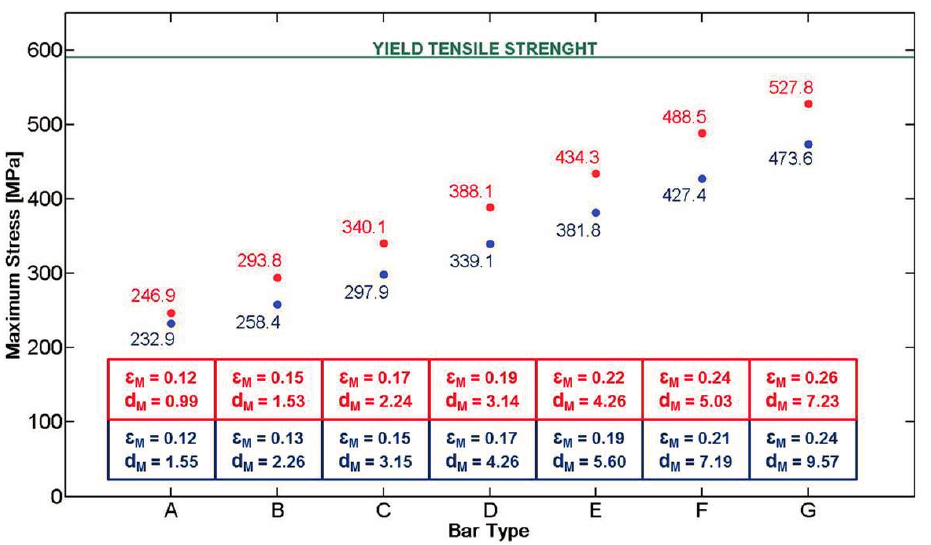
Figure 5. Graph showing the maximum stress values in correspondence to different bar types, loaded with a force of 250 N. The set of bars named “short” is represented in red, while the “long” set in blue. The values of maximum strain ( ε M [%]) and maximum deformation (d M [mm]) are reported in the boxes, for each bar